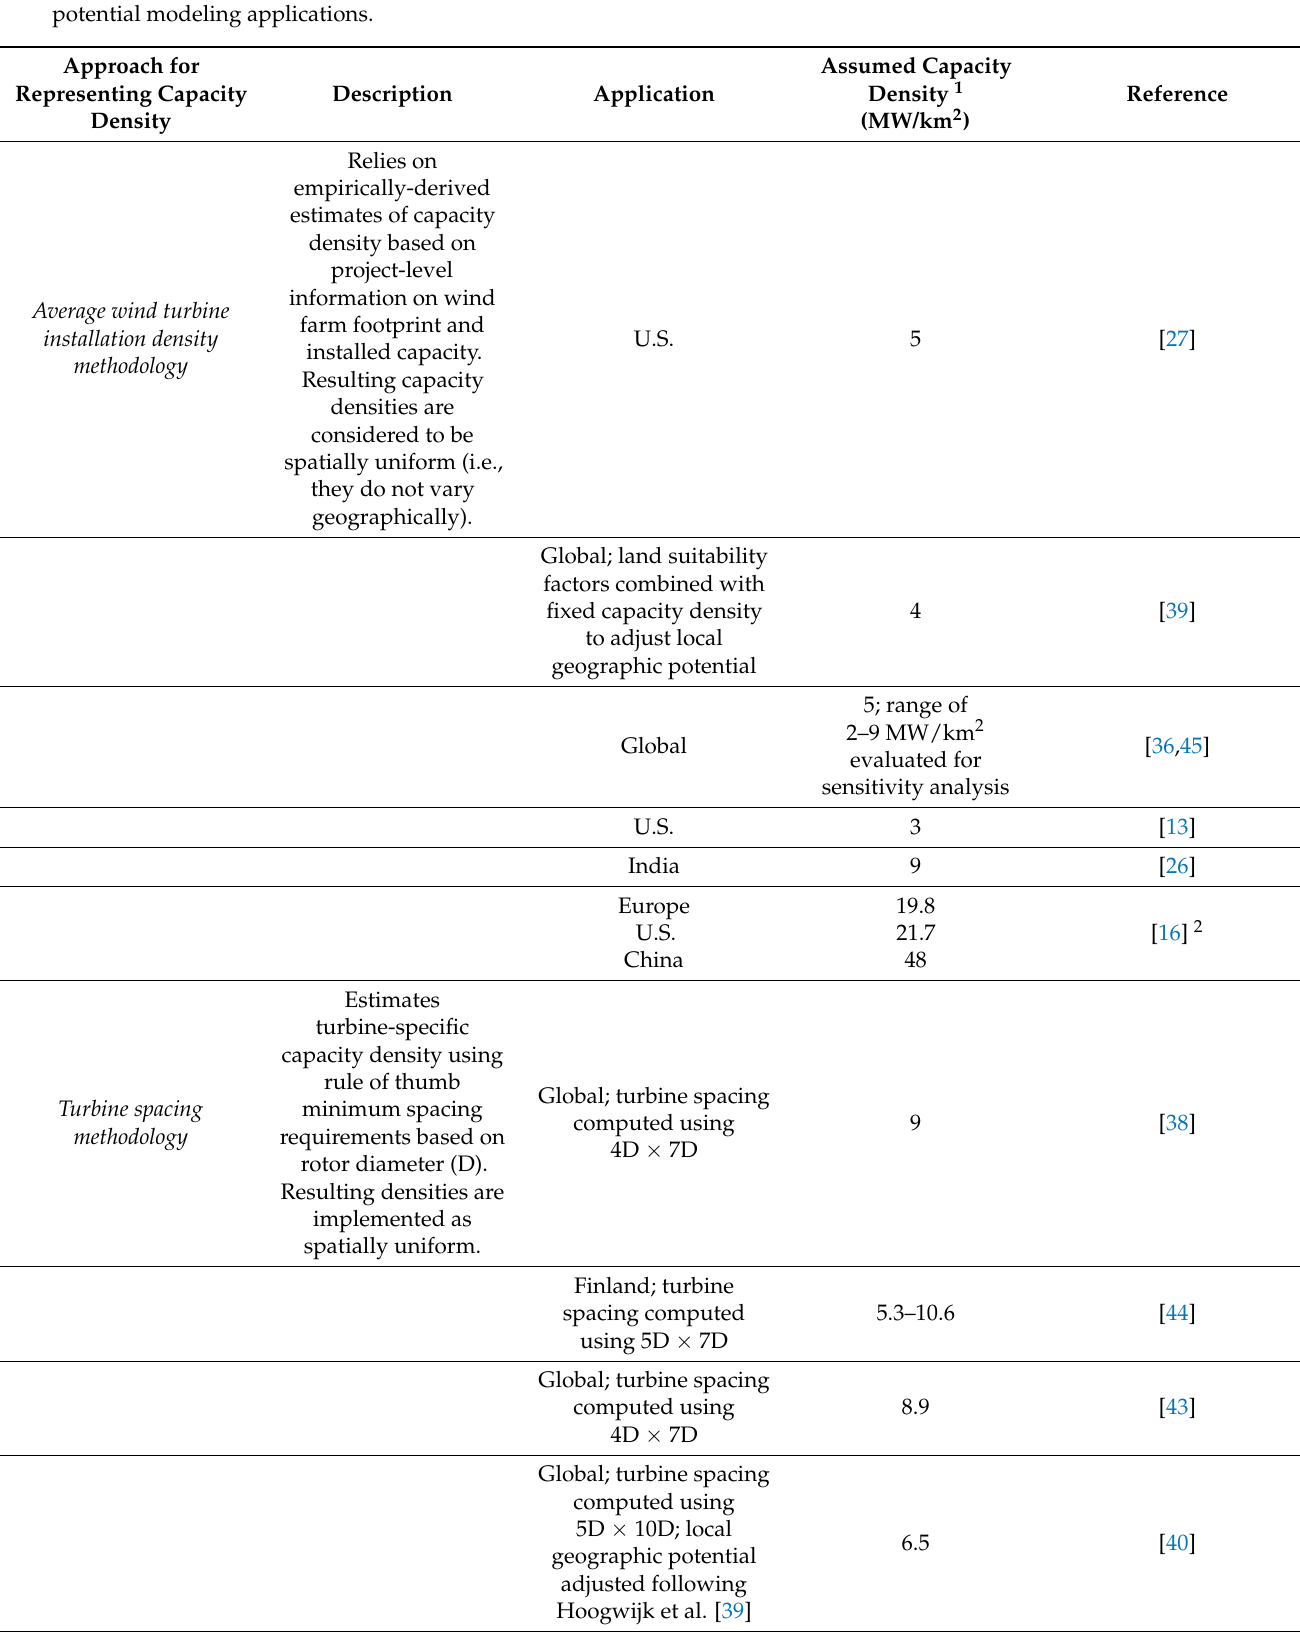
Table 1. Examples of conventional approaches to inferring spatially-uniform estimates of capacity density for wind technical potential modeling